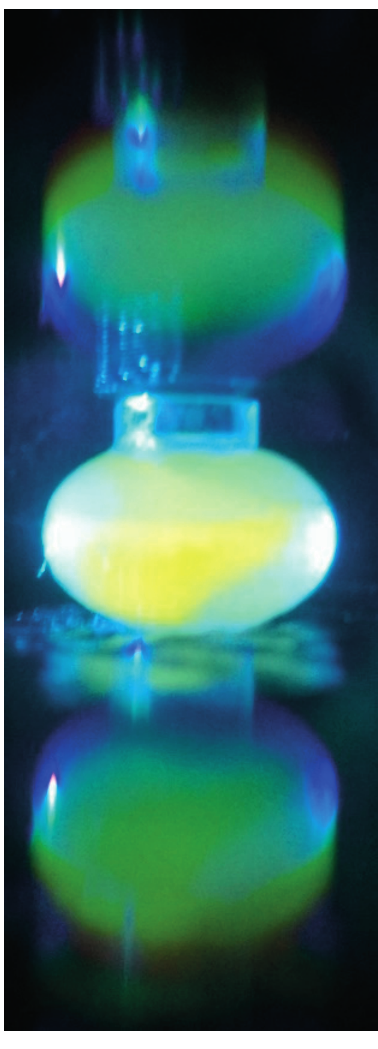
Figure 2. Image illustrating the effect of combining refractive chromatic dispersion with diffraction using a transmission grating in order to separate excitation and emission wavelengths prior to digital image